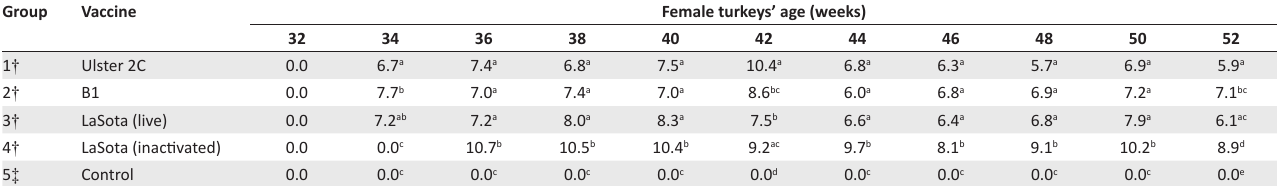
) of female bronze turkeys ( Meleagris gallopavo ) vaccinated with various commercial strains 2